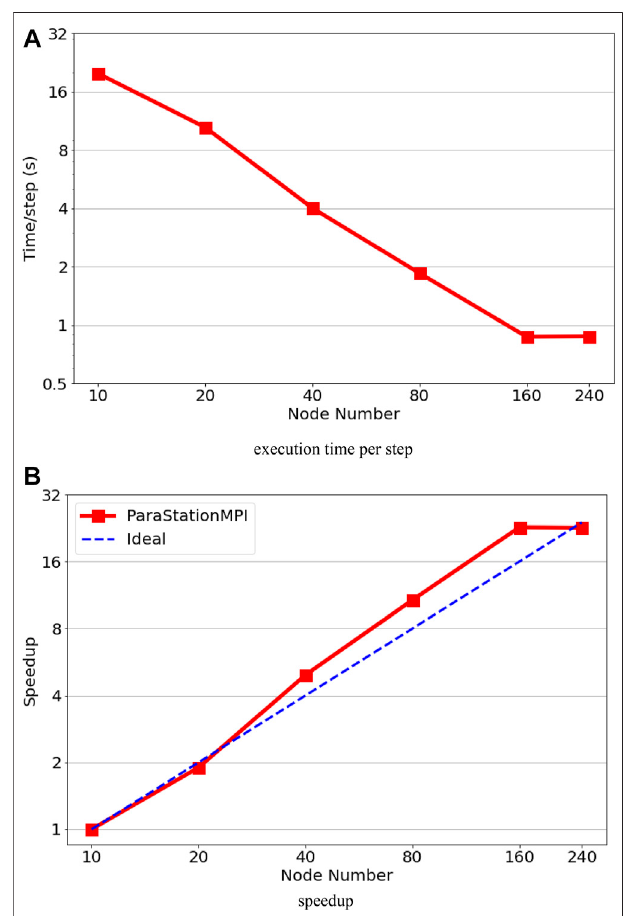
FIGURE 6 | Performance results on the JUWELS system. (A) Execution time per step. (B)